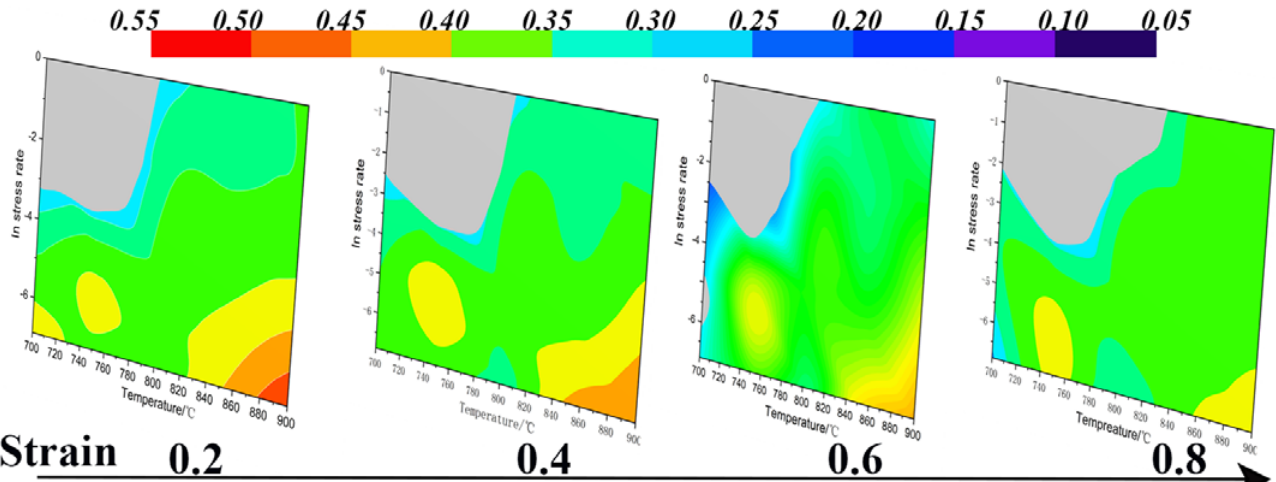
Figure 8. Hot process maps of the Cu − 9Ni − 6Sn alloy at different true strains.